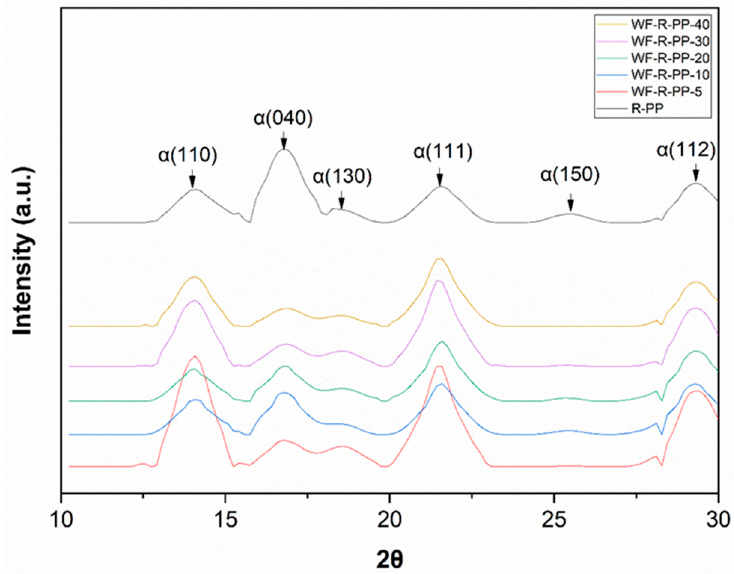
Figure 7. X-ray Di ff raction patterns of R-PP and WF-R-PP Figure 7. X ‐ ray Diffraction patterns of R ‐ PP and WF ‐ R ‐ PP composites.